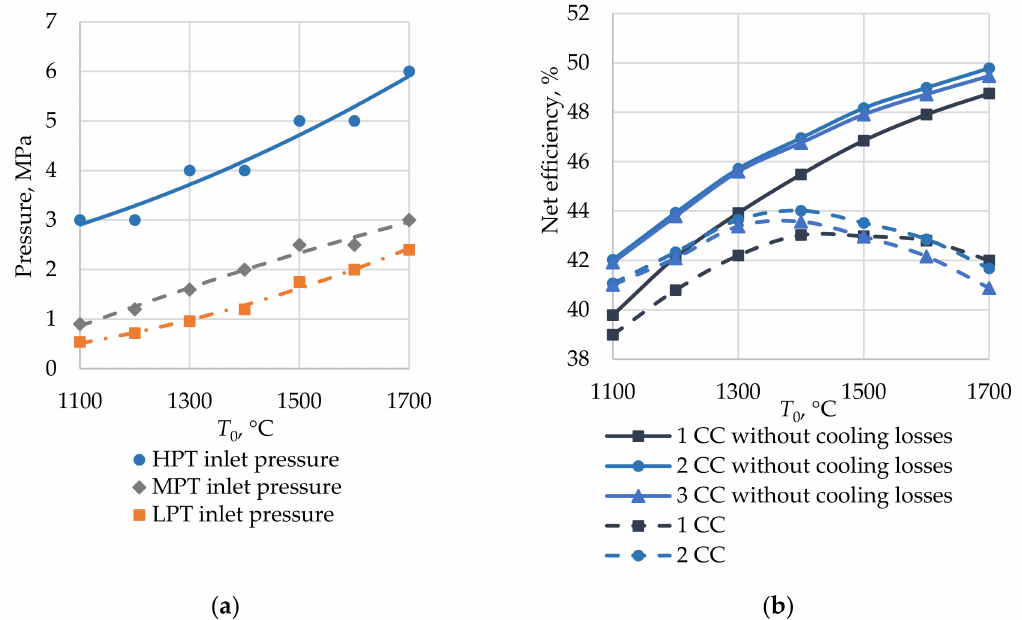
Figure 10. Results of the E-MATIANT cycle initial parameters’ optimization: ( a ) turbine inlet optimal pressure; ( b ) net efficiency vs. initial